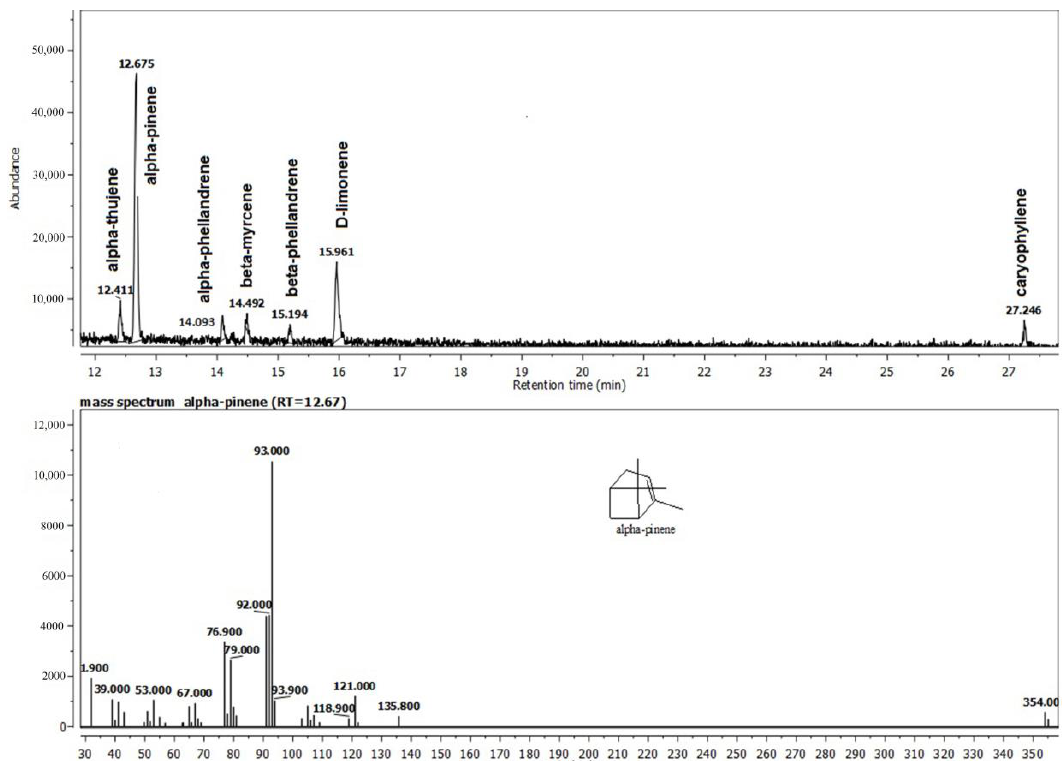
Figure 3. The composition of the Frankincense ® oil (F) recovered from the gel G2F.